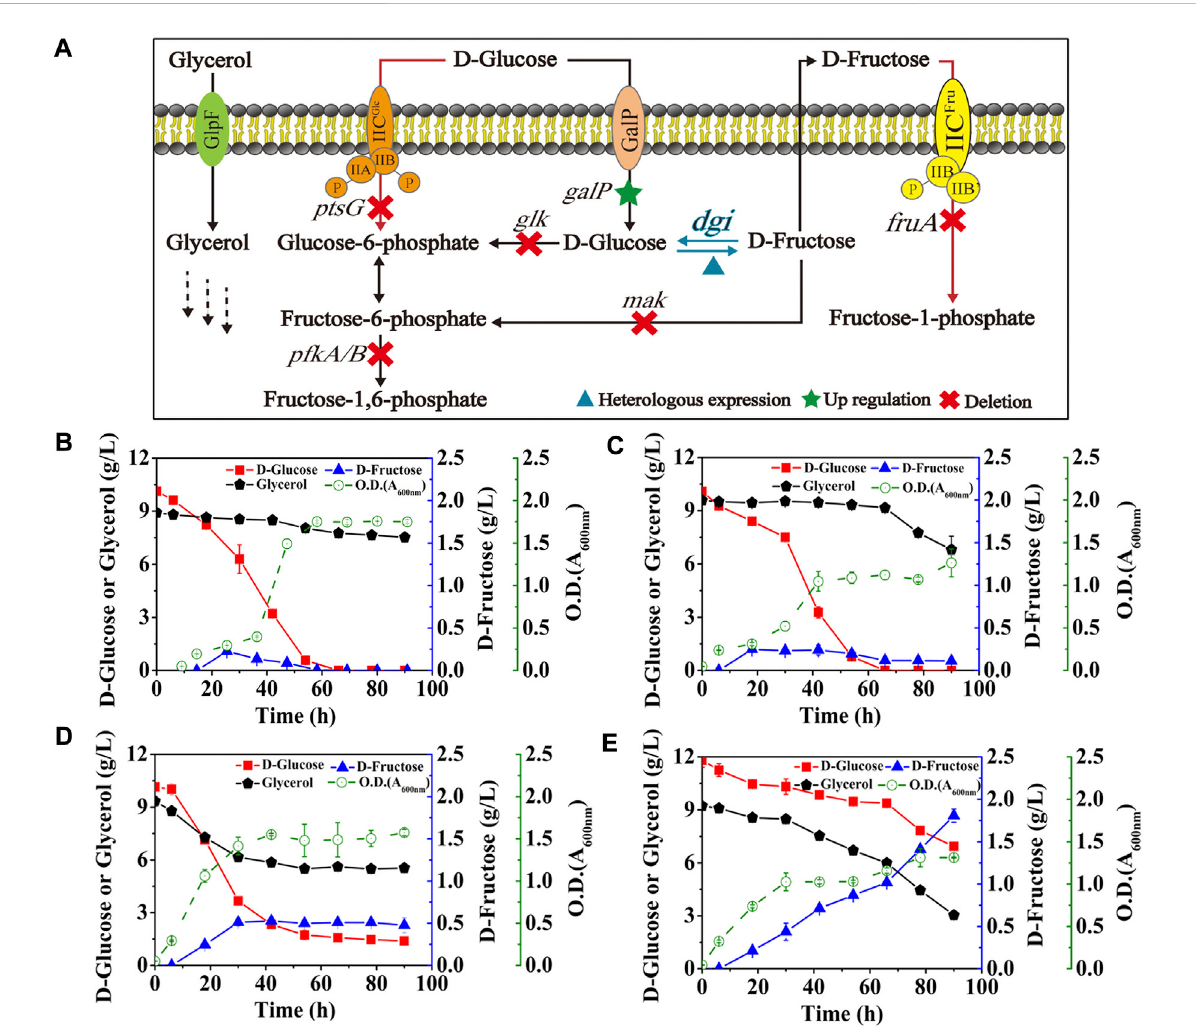
FIGURE 4 Effects of the phosphorylation acting on D-glucose and key intermediates. E. coli cells were cultured in M9 medium with D-glucose and glycerol at30 ° C. (A) Schematicofthe cell factory for D-fructose generation. (B) E. coli (DGI, GalP), (C) E. coli (DGI, GalP, Δ FruA), (D) E. coli